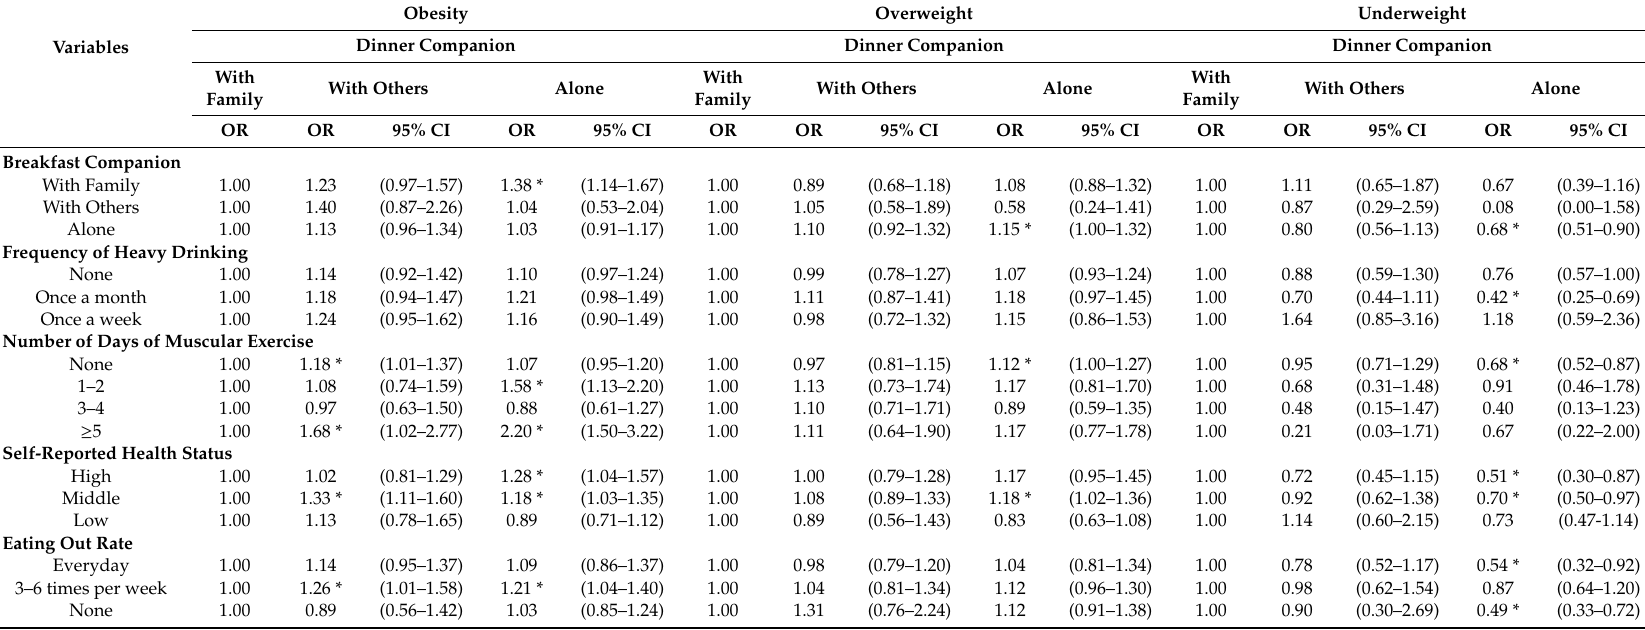
Table 3. Subgroup analysis associations between dinner companions and body mass index stratified by